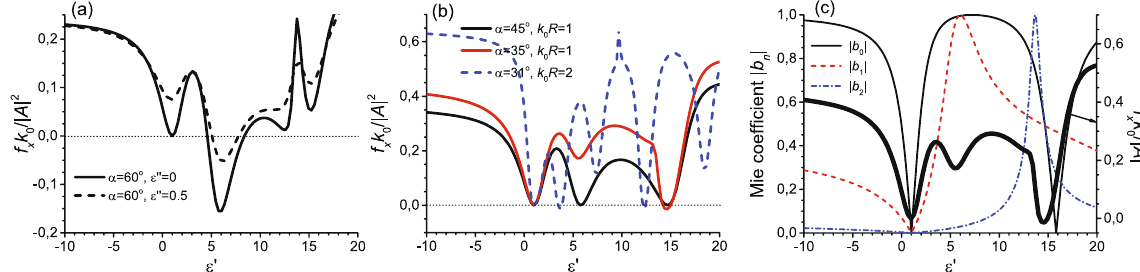
2 vs. dielectric permittivity ε ′ for ( a ) lossless and lossy Figure 2. Optical force per unit cylinder length f k A / x 0 cylindrical particles ( k 0 R = 1) and ( b ) different angles α of the oblique plane-wave incidence ( ε ″ = 0). ( c ) Absolute values of the Mie coefficients b n responsible for the appearance of induced electric dipole ( b 0 ), magnetic dipole ( b 1 ) and magnetic quadrupole ( b 2 ) moments (the force shown on the right-hand axis corresponds to parameters α = 35°, k 0 R = 1). Incident beam is TE-polarized ( B = 0). The cylinder is nonmagnetic ( μ = 1) and